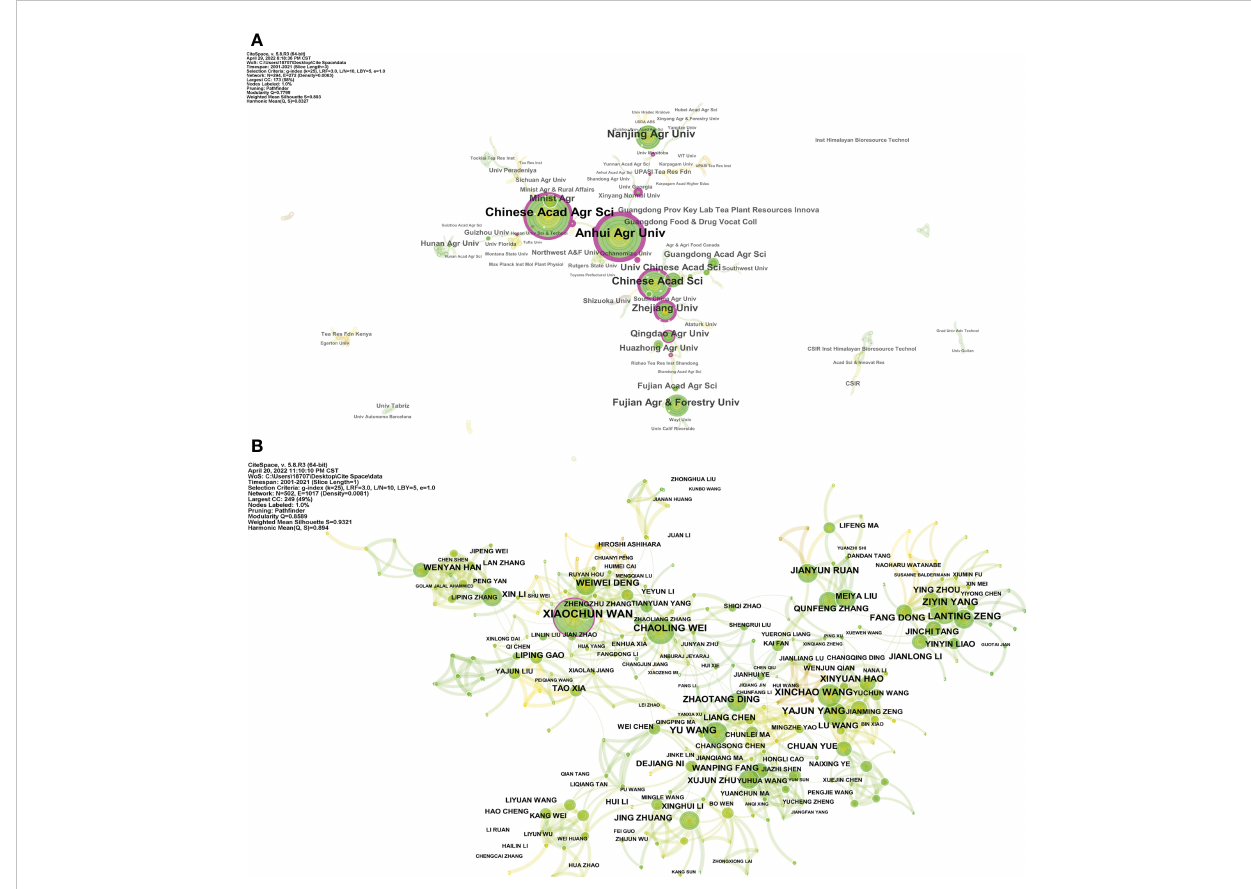
FIGURE 5 Collaboration network of (A) institutions and (B) authors, generated with CiteSpace. The size of each node represents the citations of each institution or author. Colors closer to the middle of the node represent earlier publication years, whereas exterior colors are more recent publication years. The purple circle means the node ’ s centrality ≥ 0.1, and the size of the circle is proportional to the centrality